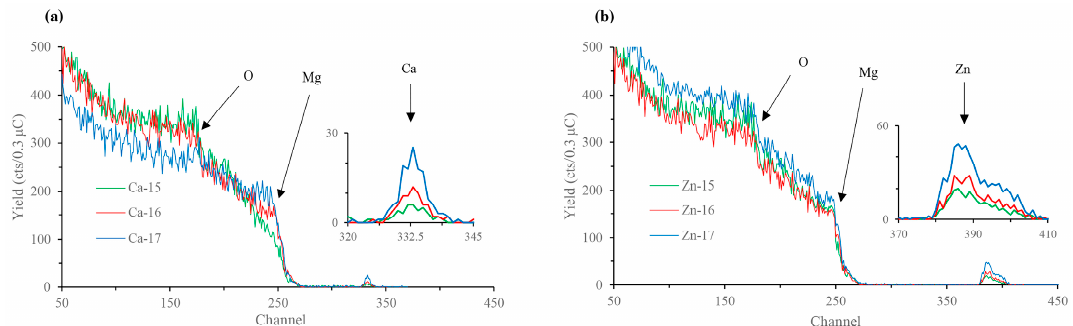
Figure 1. Rutherford backscattering (RBS) spectra of: ( a ) Ca-ion; and ( b ) Zn-ion implanted magnesium.